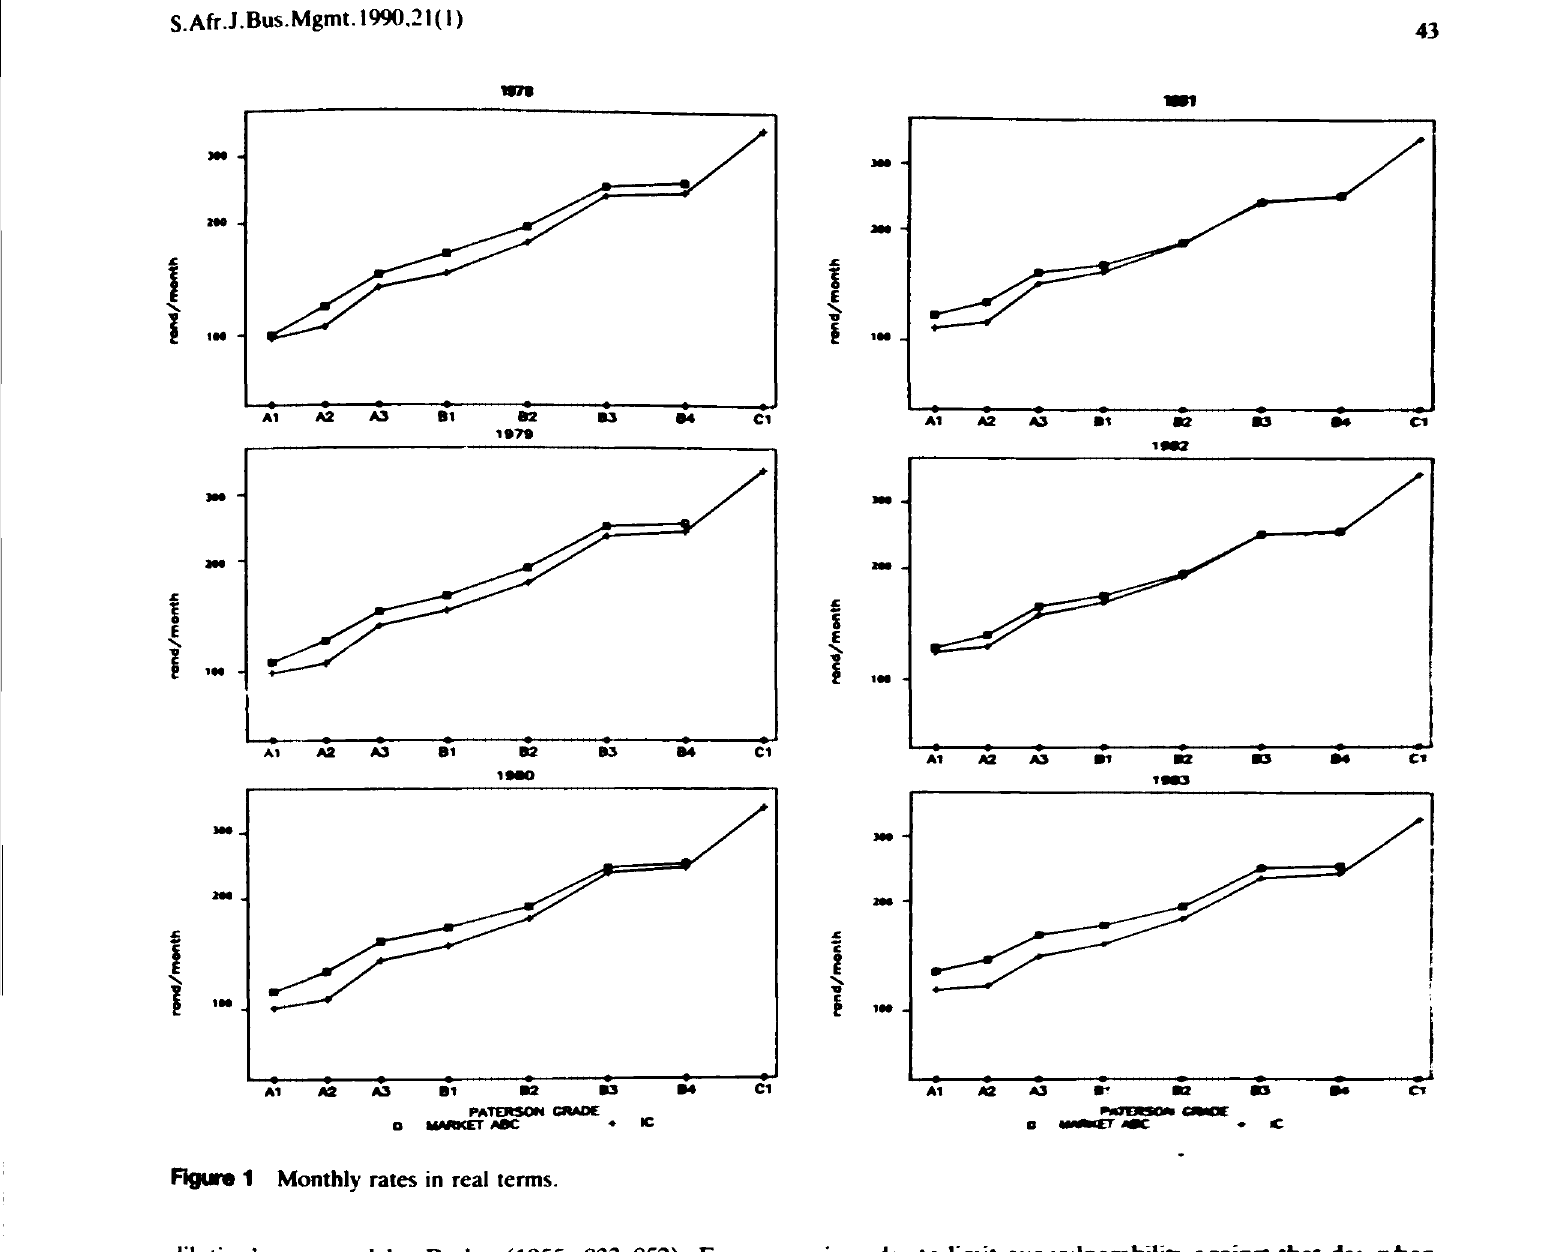
Figln 1 Monthly rates in real